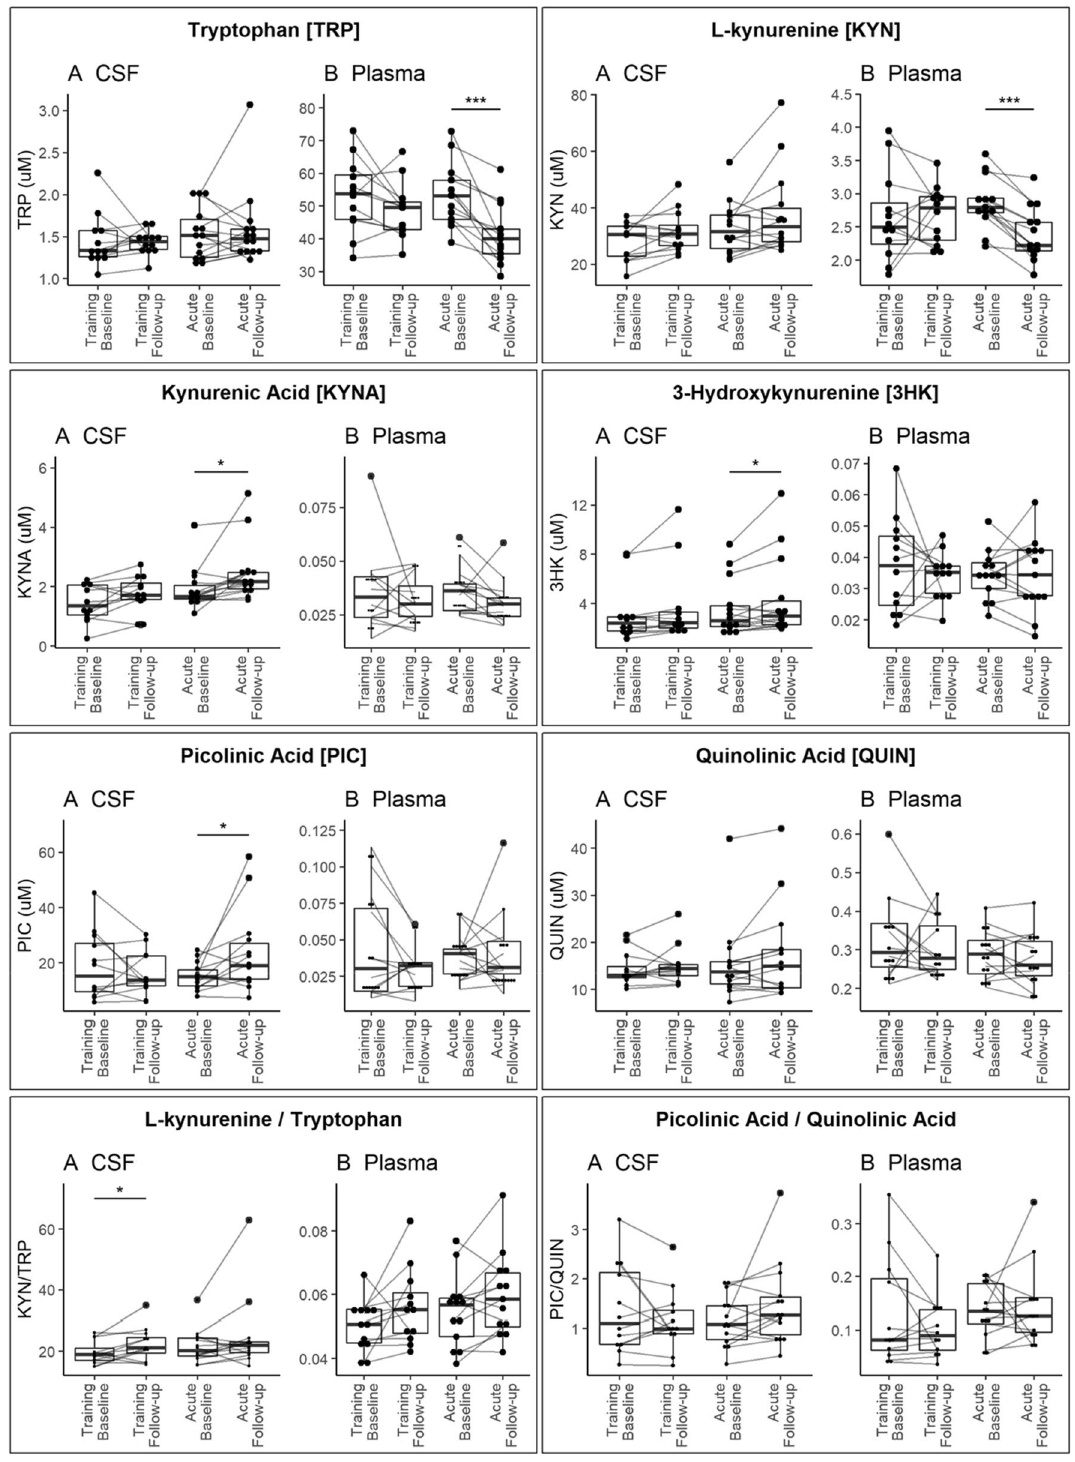
Figure 3. Distribution of tryptophan and kynurenine pathway metabolite levels in cerebrospinal fluid and plasma, stratified by intervention. Box and dot plots illustrate metabolite levels (μM) in ( A ) cerebrospinal fluid (CSF) and ( B ) plasma among paired samples (line) before and after either training or acute intensity aerobic exercise. Significance was determined across groups (solid bar). Significance levels ( P ): (*) < 0.05, (**) < 0.01, and (***) < 0.005. R: A language and environment for statistical computing. R Foundation for Statistical Computing, Vienna, Austria. URL https:// www.R- proje ct.